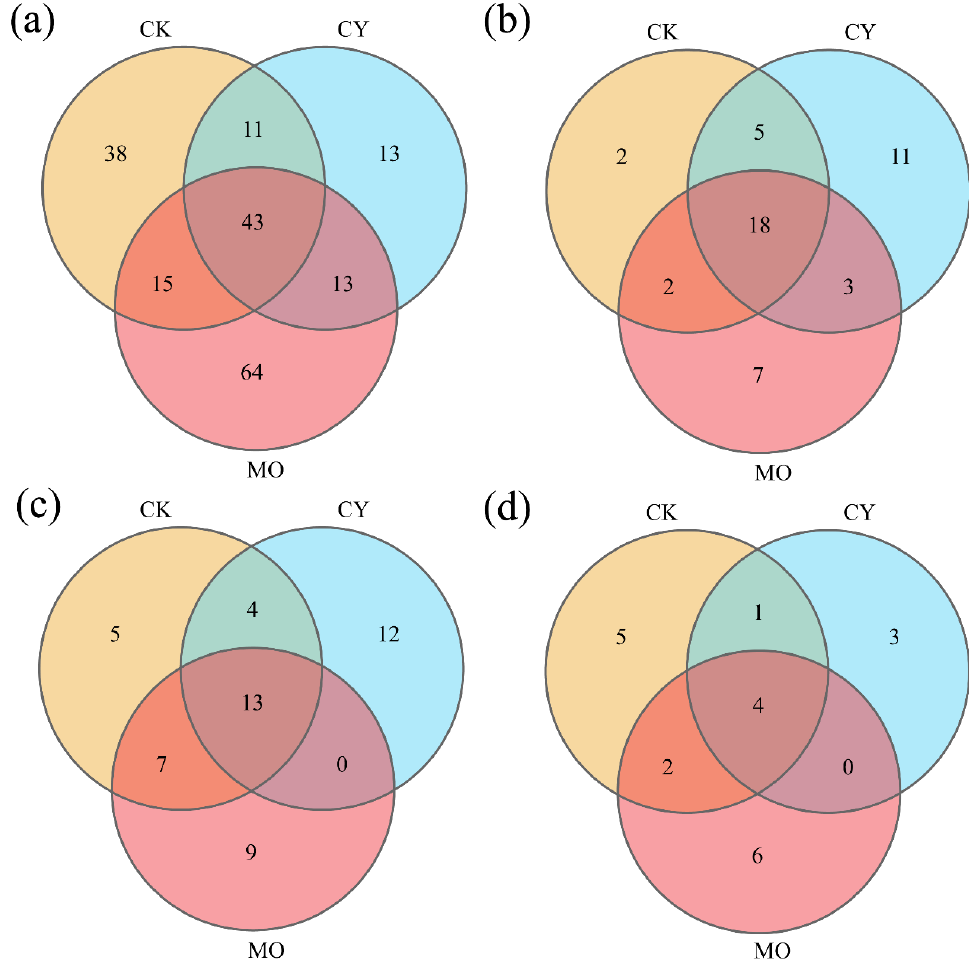
Figure 2. Venn diagram analysis of the common and specific species of each group: ( a ) bacteria, ( b ) phytoplankton, ( c ) zooplankton, and ( d ) fungi.